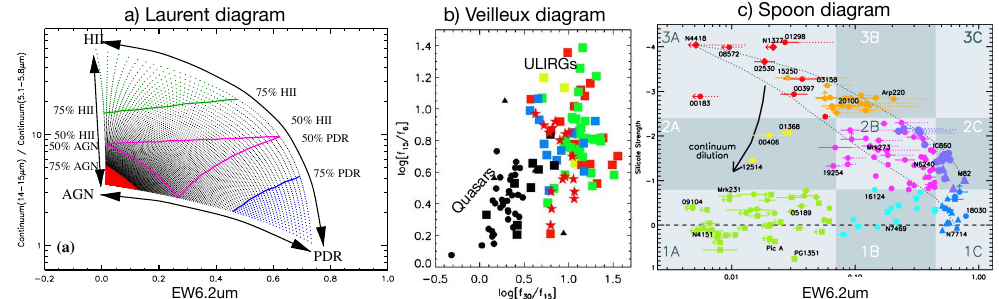
indicates a mixing diagram between AGN-like, HII region-like and PDR-like spectra involving the PAH equivalent width and the mid-IR 15-to-5 µ m continuum color. Adapted from Laurent et al. [79], Fig.5. a Diagnostic diagram based on CVF spectra. b Diagnostic diagram based on broad band filters. Three distinct areas can be defined. In © ESO. ( b ) The “Veilleux diagram” [74] shows the same 15 to 5 µ m continuum color on the y-axis, but the upper corner, we select spectra dominated by massive HII regions such as those found in starbursts. On the lower left, AGN spectra are dominant in a very small region, and finally, PDR spectra fall in the lower right part. The solid lines and the associated percentages indicate a now compares it with the 30 to 15 µ m color on the x-axis. All black symbols represent Seyfert 1 optical constantfractionofonecomponentalongeachline(seeSect.4.3). spectra, the blue squares are Seyfert 2 optical spectra. All other colors and the star symbols indicate sources with pure star-forming optical spectra. Adapted from Veilleux et al. [74], © AAS. ( c ) The “Spoon diagram” [80] has the same x-axis as the Laurent diagram but has the depth of the silicate feature along the y-axis, highlighting a potential embedded nucleus evolutionary phase.